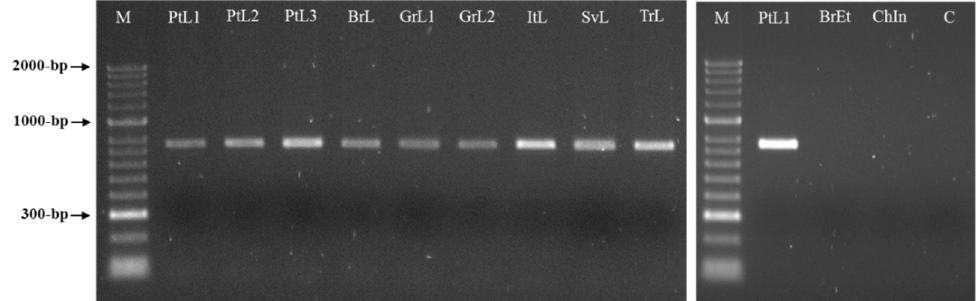
Figure 3. SCAR-PCR products (~770 bp specific fragment) for Meloidogyne luci (isolates PtL1, PtL2, PtL3, BrL, GrL1, GrL2, ItL, SvL, TrL), M. ethiopica (isolate BrEt) and M. inornata (isolate ChIn) using the species-specific primer pair Mlf/r. For isolate codes see Table 1. M—DNA marker (HyperLadder II, Bioline); C—Negative control.